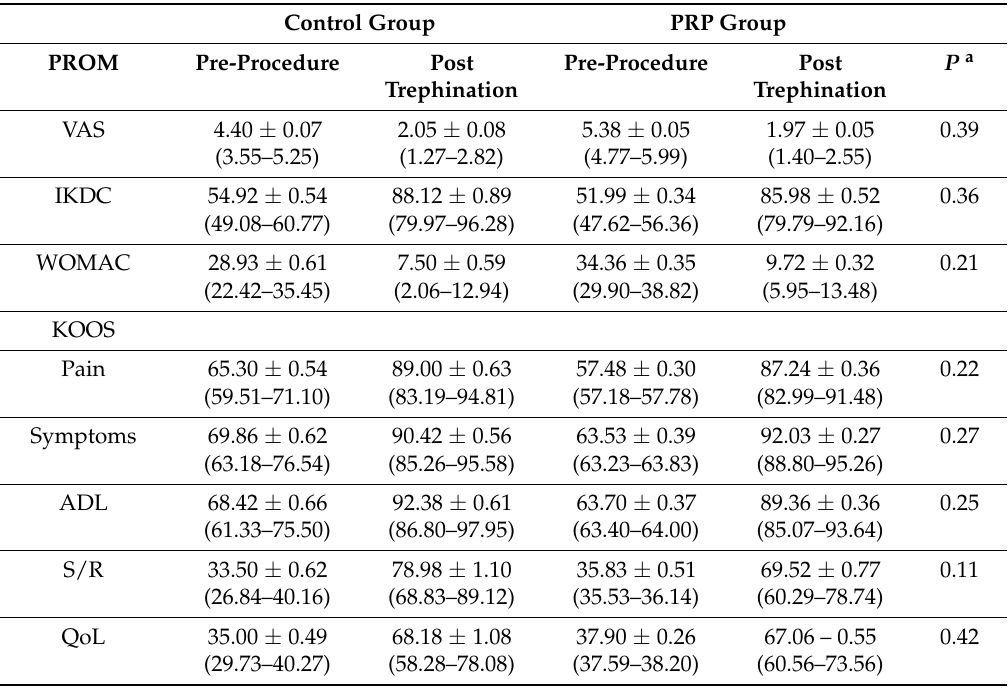
Table 3. Patient-reported outcome measures (pain: VAS and KOOS-pain; function: IKDC, WOMAC, KOOS: symptom, ADL, sport/recreation and